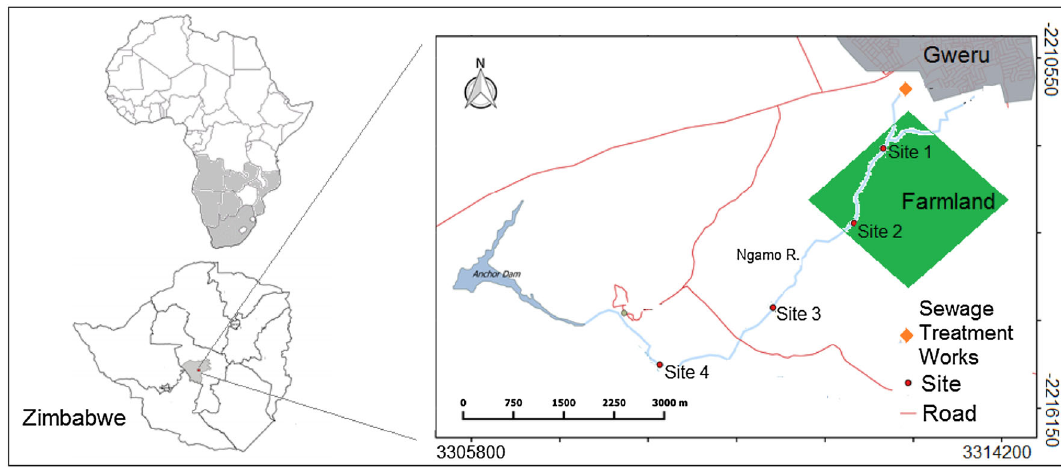
Fig. 1 Map showing study locations near Gweru urban area, Midlands Province,